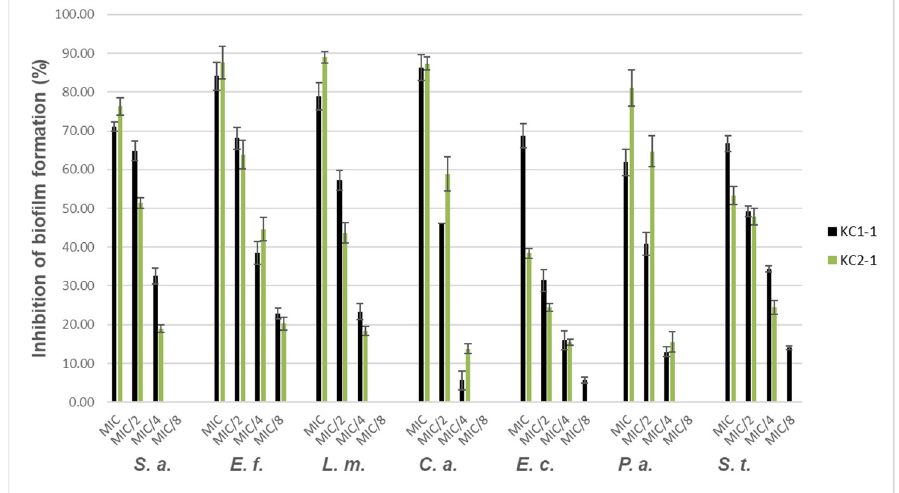
Figure 2. Antibiofilm activity of propolis and cerumen extracts. Note: S. a. ( S. aureus ATCC 25923); E. f. ( E. faecalis ATCC 29212); L. m. ( L. monocytogenes ATCC 7644); C. a. ( C. albicans ATCC 10239); E. c. ( E. coli ATCC 25922); P. a. ( P. aeruginosa ATCC 27853); S. t. ( S. typhi ATCC 14028).